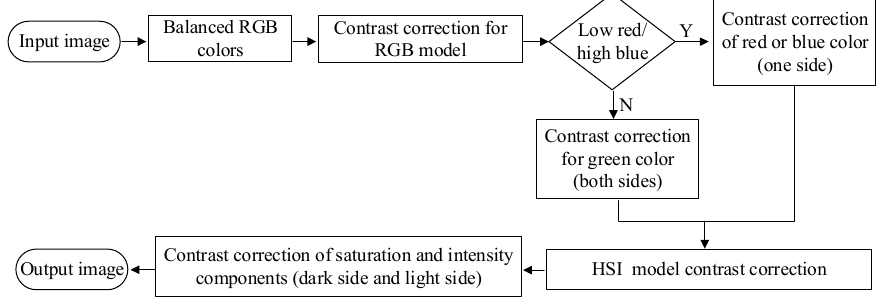
Figure 2. Unsupervised color correction (UCM) algorithm flowchart.